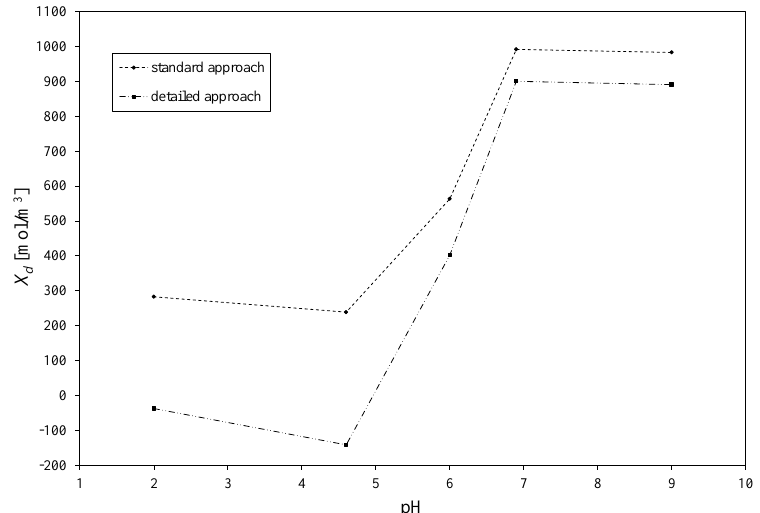
Figure 3. Comparison of estimated total volume membrane charge densities X d for standard and proposed modelling approach with detailed described DSPM model, for aqueous solution of Cu(NO 3 ) 2 .